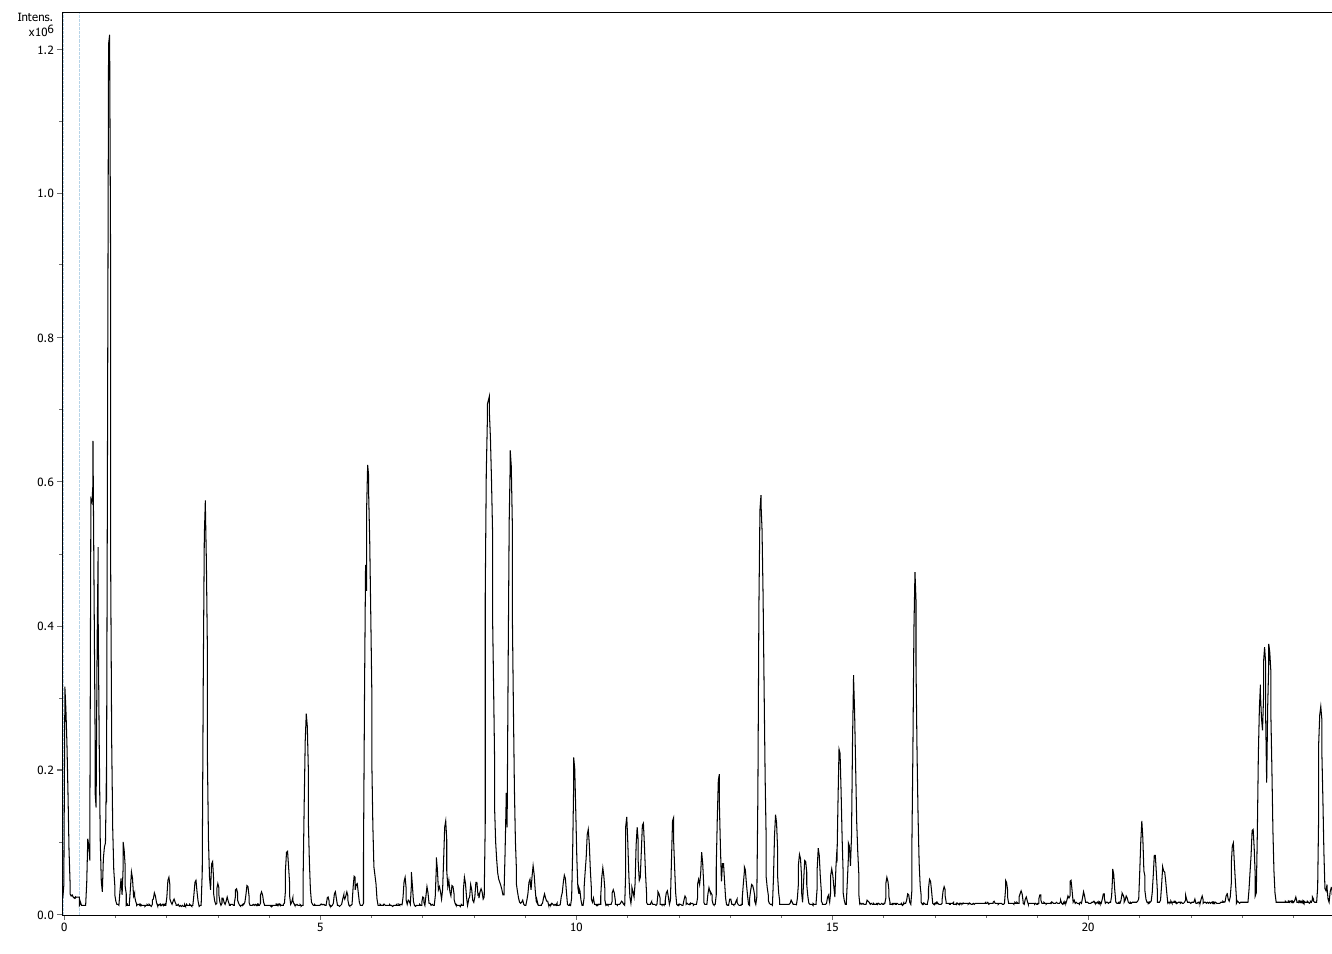
Figure A4. Ilex aquifolium L. leaves water extract, basic peak chromatogram, negative mode.